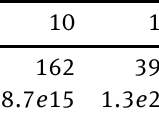
Table 1: The number a ( n ) of acute 0/1 n -simplices in I n related to their total number s ( n ) . All cardinalities are modulo the ac- tion of B n